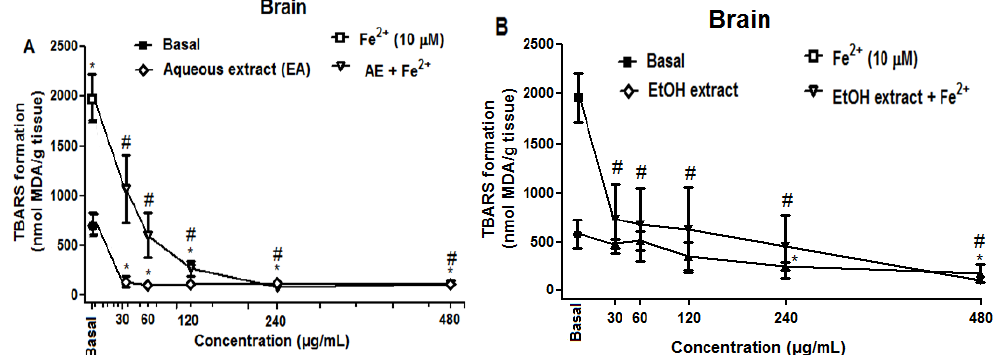
Figure 3. Effect of aqueous ( A ) and ethanolic ( B ) extracts of the leaves of R. echinus on lipid peroxidation induced by iron in rat brain homogenates. The homogenate was incubated for 1 h with Fe 2+ (10 μ M) in the presence or absence of different concentrations of the extracts. Values represent the mean of n = 3 independent experiments performed in duplicate ± SEM. *: p < 0.05 vs. basal and #: p < 0.05 vs. Fe 2+ . Similar to that observed with brain homogenates, crude extracts of R. echinus inhibited LPO induced by Fe 2+ in rat liver homogenates (Figure 4). In contrast, ethanolic extract (EtOH extract) did not inhibited TBARS formation under basal condition (Figure 4B), while aqueous extract (AE) inhibited TBARS production under basal conditions (Figure 4A).